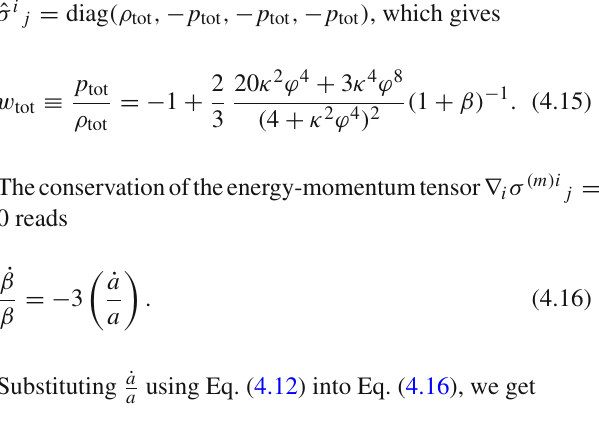
Fig. 2 w tot ( z ) defined in Eq. (5.14) from z = 1 to z = − 1 with ϕ( 1 ) = 0 . 1, β( 1 ) = 0 . 01, κ = 1, and (cid:24)